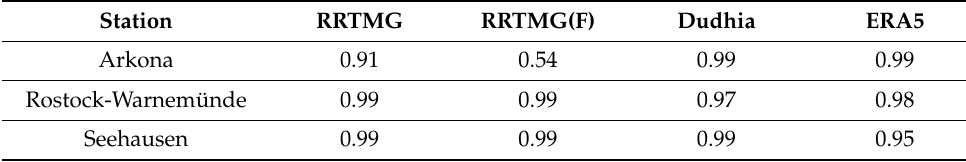
Table 3. Summary of correlation coefficients for high